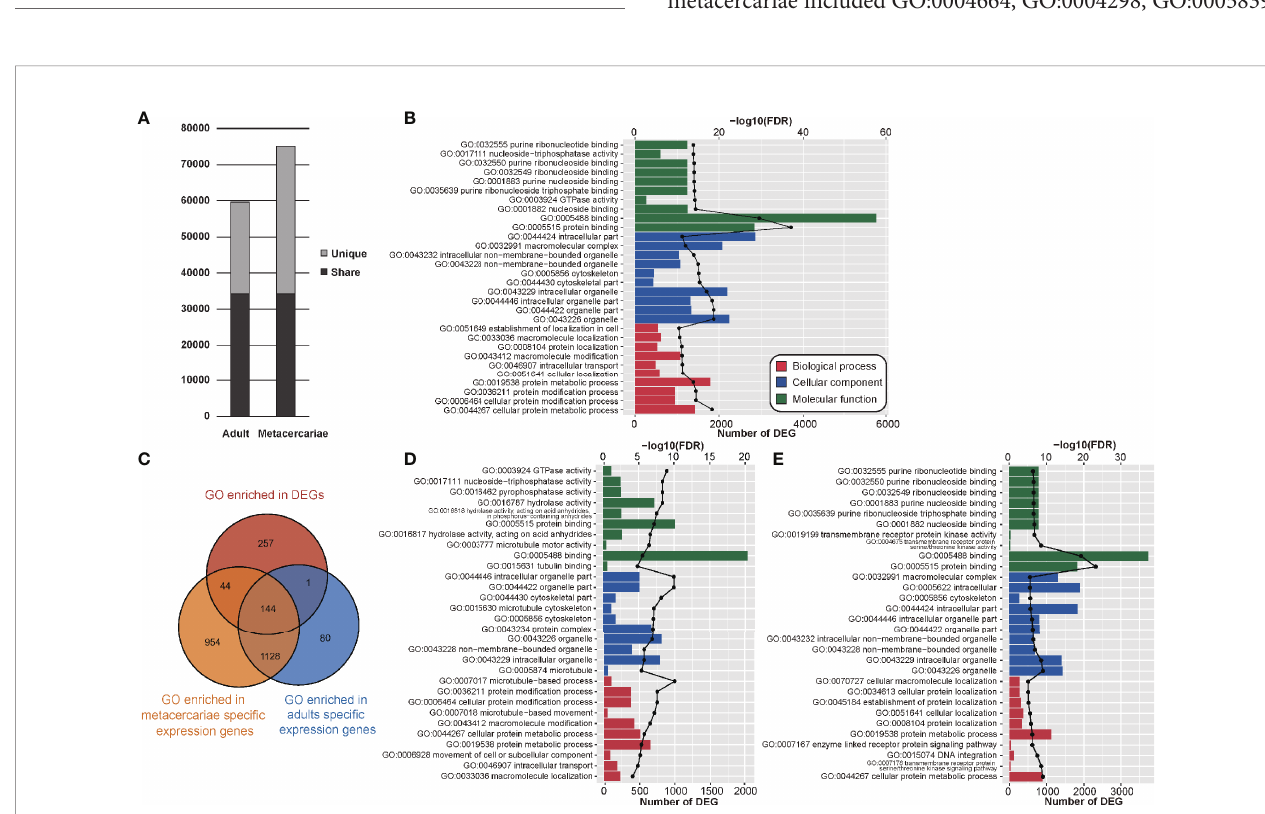
FIGURE 2 | The results of transcriptome analyses between adult stage and metacercariae stage. (A) The bar chart shows the number and sharing of genes expressed in adult stage and metacercariae stage. (B) Demonstrated the gene ontology (GO) assigned to the DEGs. (C) Demonstrated the relationship between the enrichment function and stage-speci fi c genes. (D) Enrichment of up-regulated and down-regulated DEGs (adult versus metacercariae) in GO function. (E) Enrichment of down-regulated DEGs (adult vs metacercariae) in GO